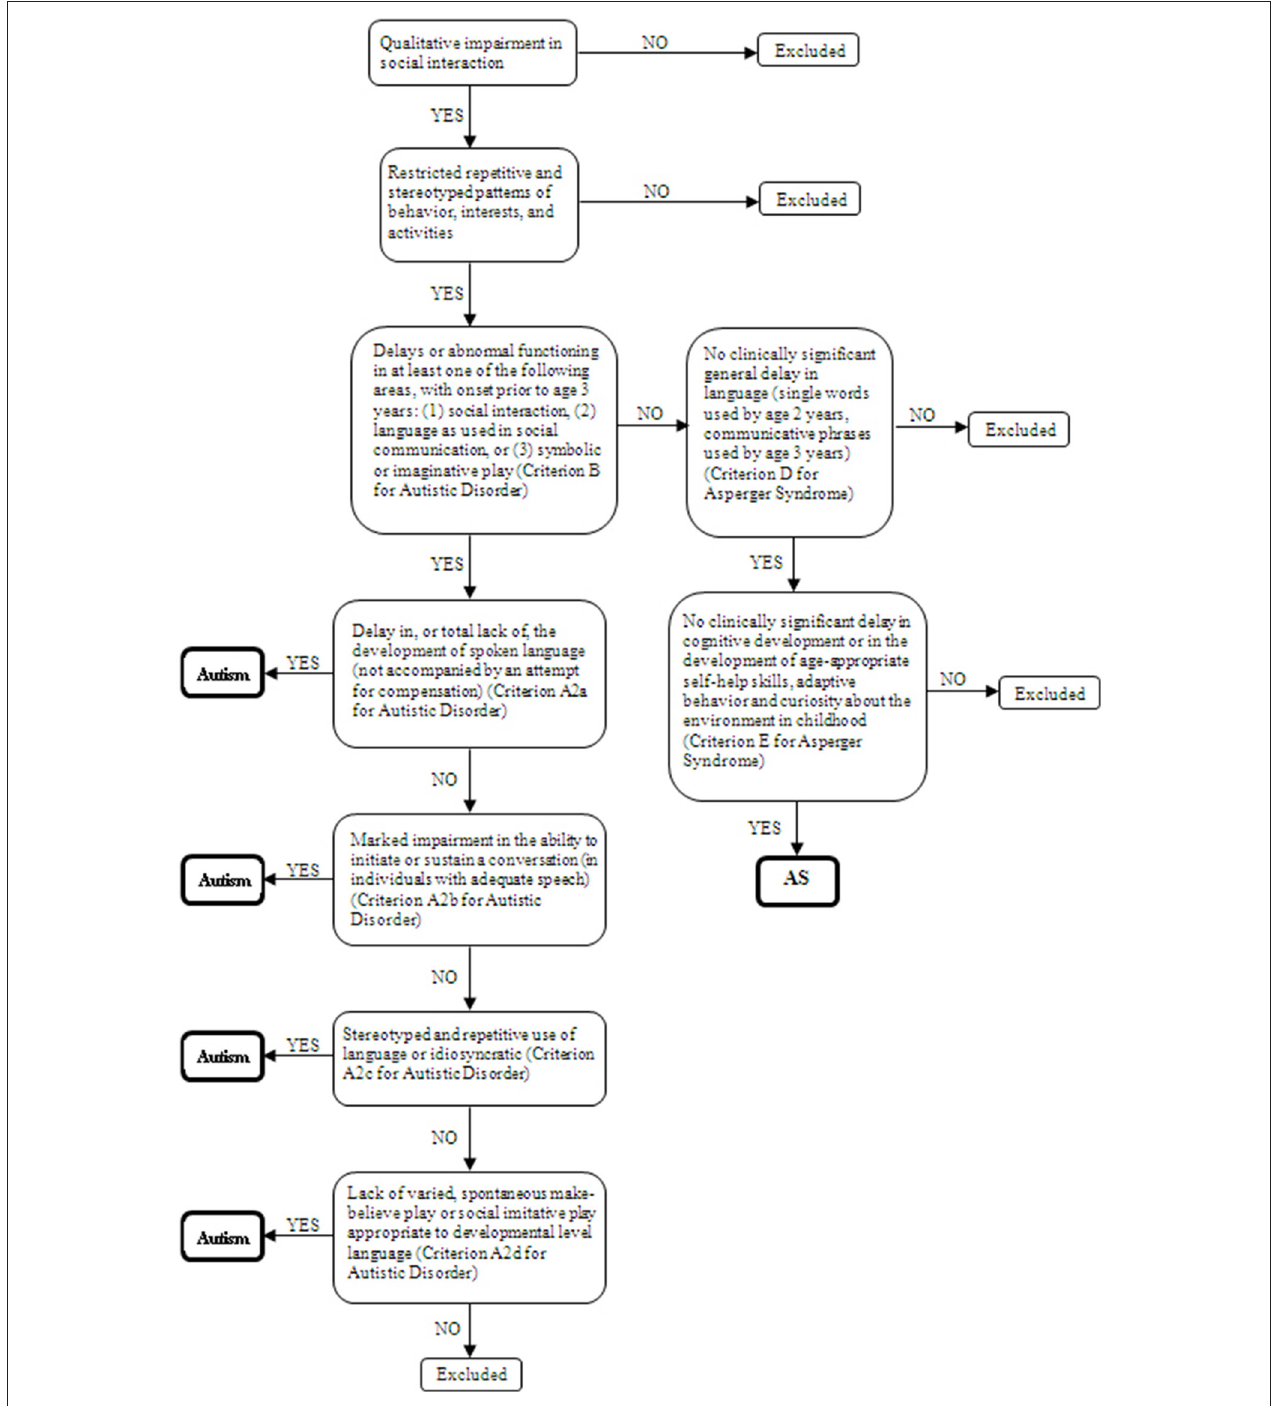
FIGURE 1 | Decision tree based on the DSM-4 criteria for autism and Asperger Syndrome classification.